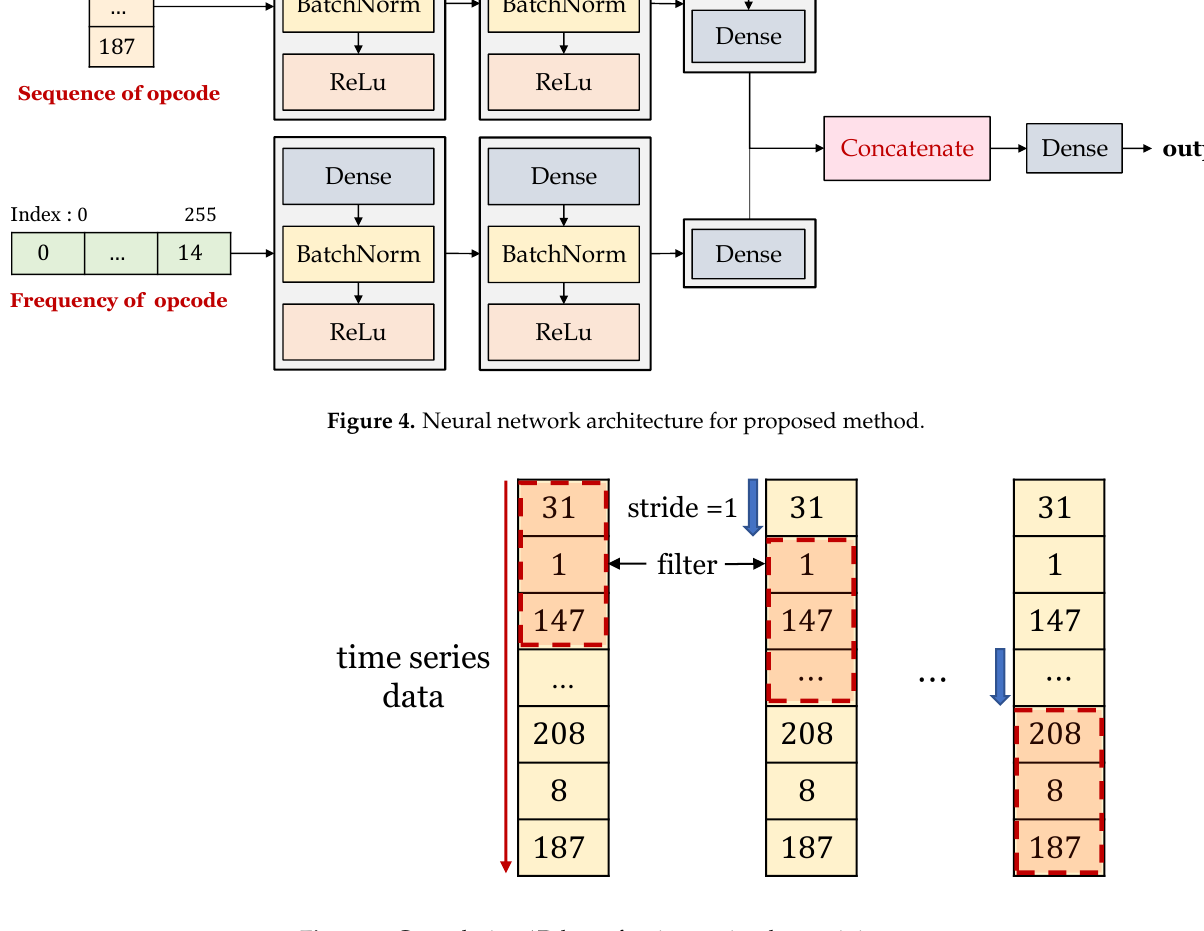
Figure 5. Convolution 1D layer for time series data